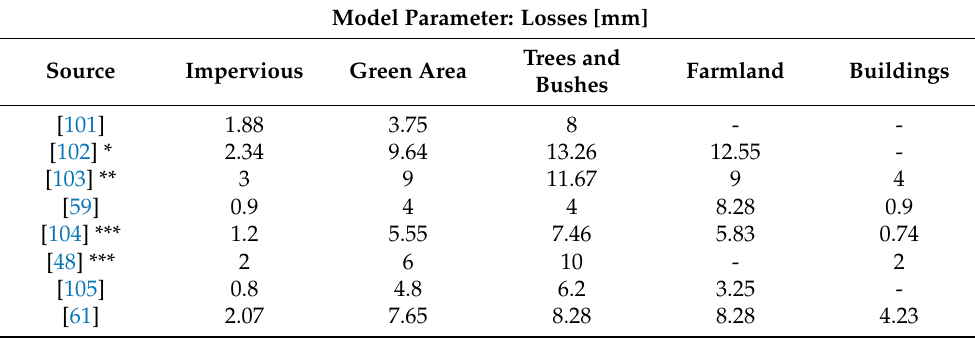
Table A2. Overview of the model parameters surface roughness for urban flood models.